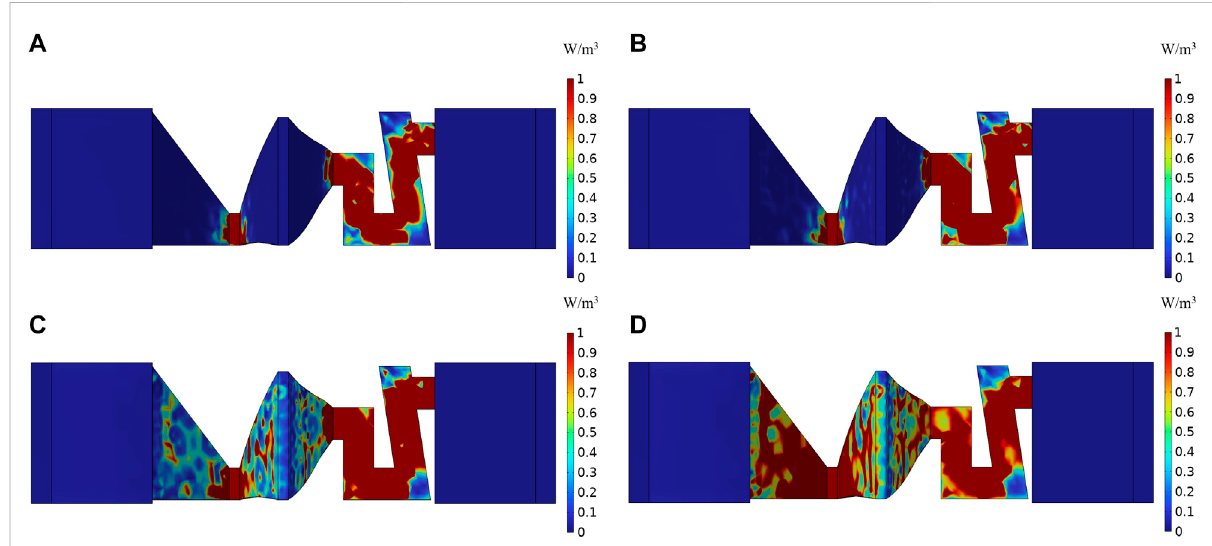
FIGURE 6 Thermal-power density distribution of the cavity ABH. (A) f = 40 Hz; (B) f = 200 Hz; (C) f = 1250 Hz; (D) f = 3150 Hz.